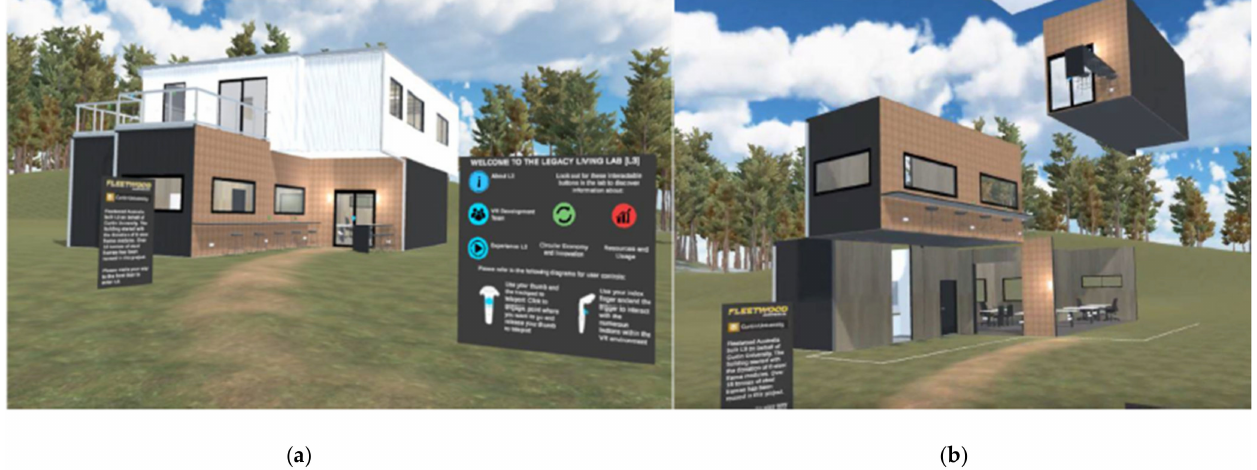
Figure 5. ( a ) Hero image is the starting sequence for the VR environment. ( b ) Modules falling into position show how the building was installed on site in the construction sequence.